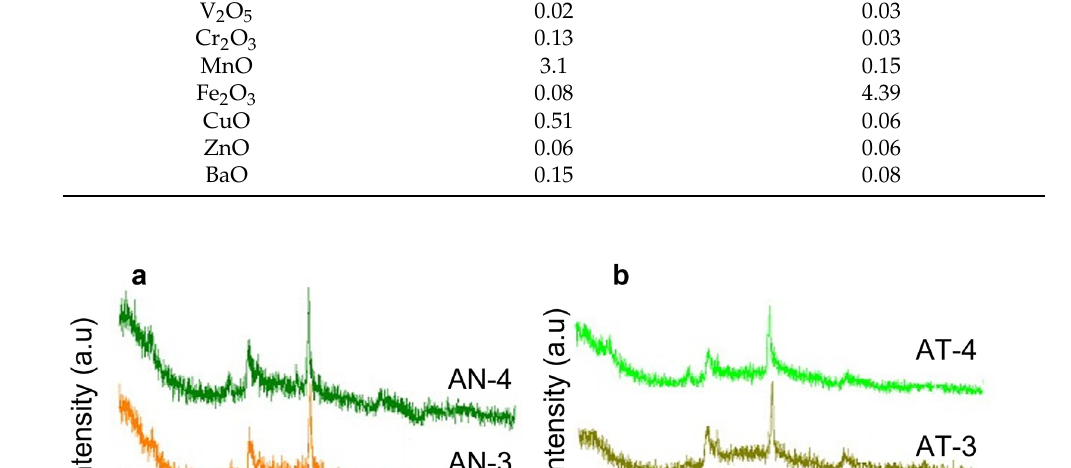
Table 1. Variations in composition of the Indonesian kaolin before and after treatment. Composition (%b/b) Compound Raw Kaolin Treated Kaolin Al 2 O 3